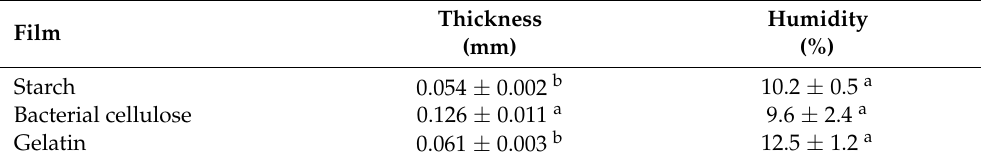
Table 1. Width and humidity (mass basis) of the starch, bacterial cellulose, and gelatin films. For each property, values followed by at least one common letter are not different from each other ( p > 0.05).